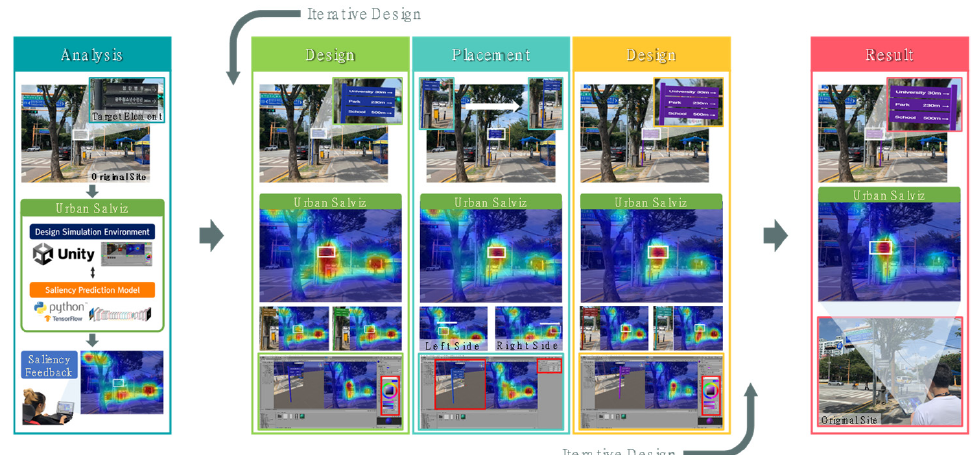
Figure 1. Incorporating saliency to iteratively enhance the conspicuity of a sign. Pedestrian attention is visualized throughout the design process, including site analysis, implementation, iteration, and installation. In this case, desginers can simulate the amount of attention paid to wayfinding signs with different color and position (boxed elements in the mixed reality